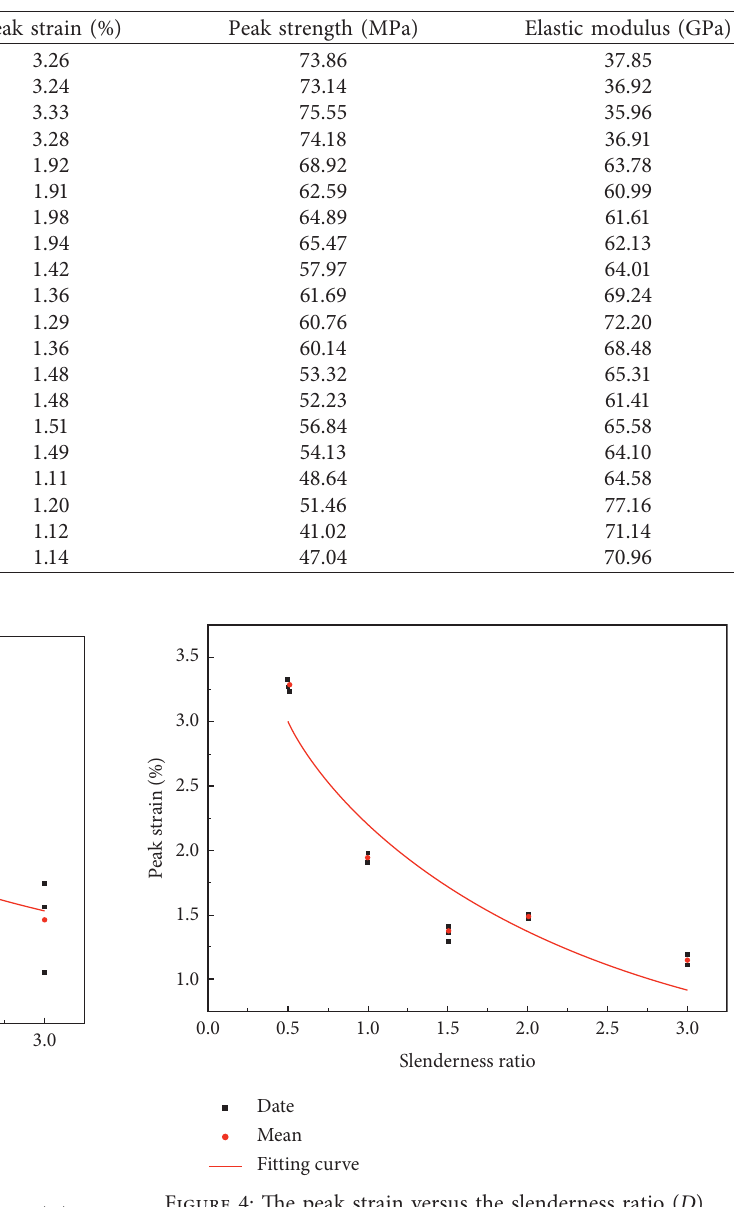
Table 1: Uniaxial compression tests parameters and mean results.